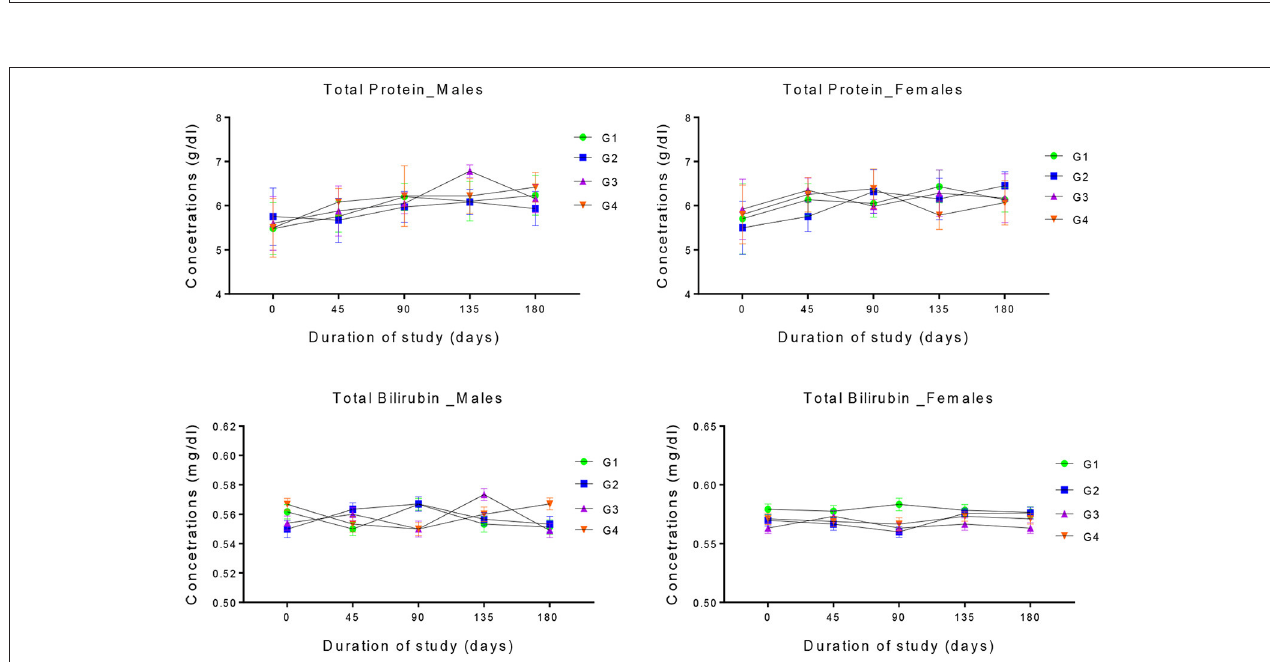
FIGURE 4 | Changes in the levels of serum total Protein and total Bilirubin in the four experimental groups of male and female rabbits. group. G1 control group, G2, G3, and G4 represent 20, 30, and 40% GM cottonseed respectively. Two-way ANOVA indicated non-significant differences between groups, sampling periods and their interaction ( P >